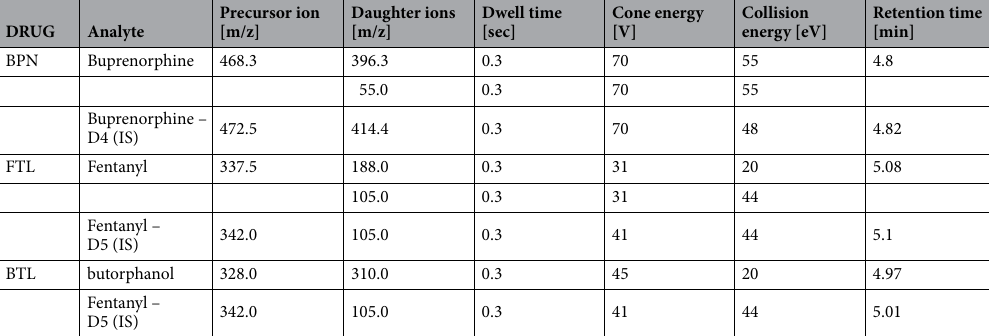
Table 1. Characterisation of analytical methods developed for buprenorphine, fentanyl and butorphanol determination in cell